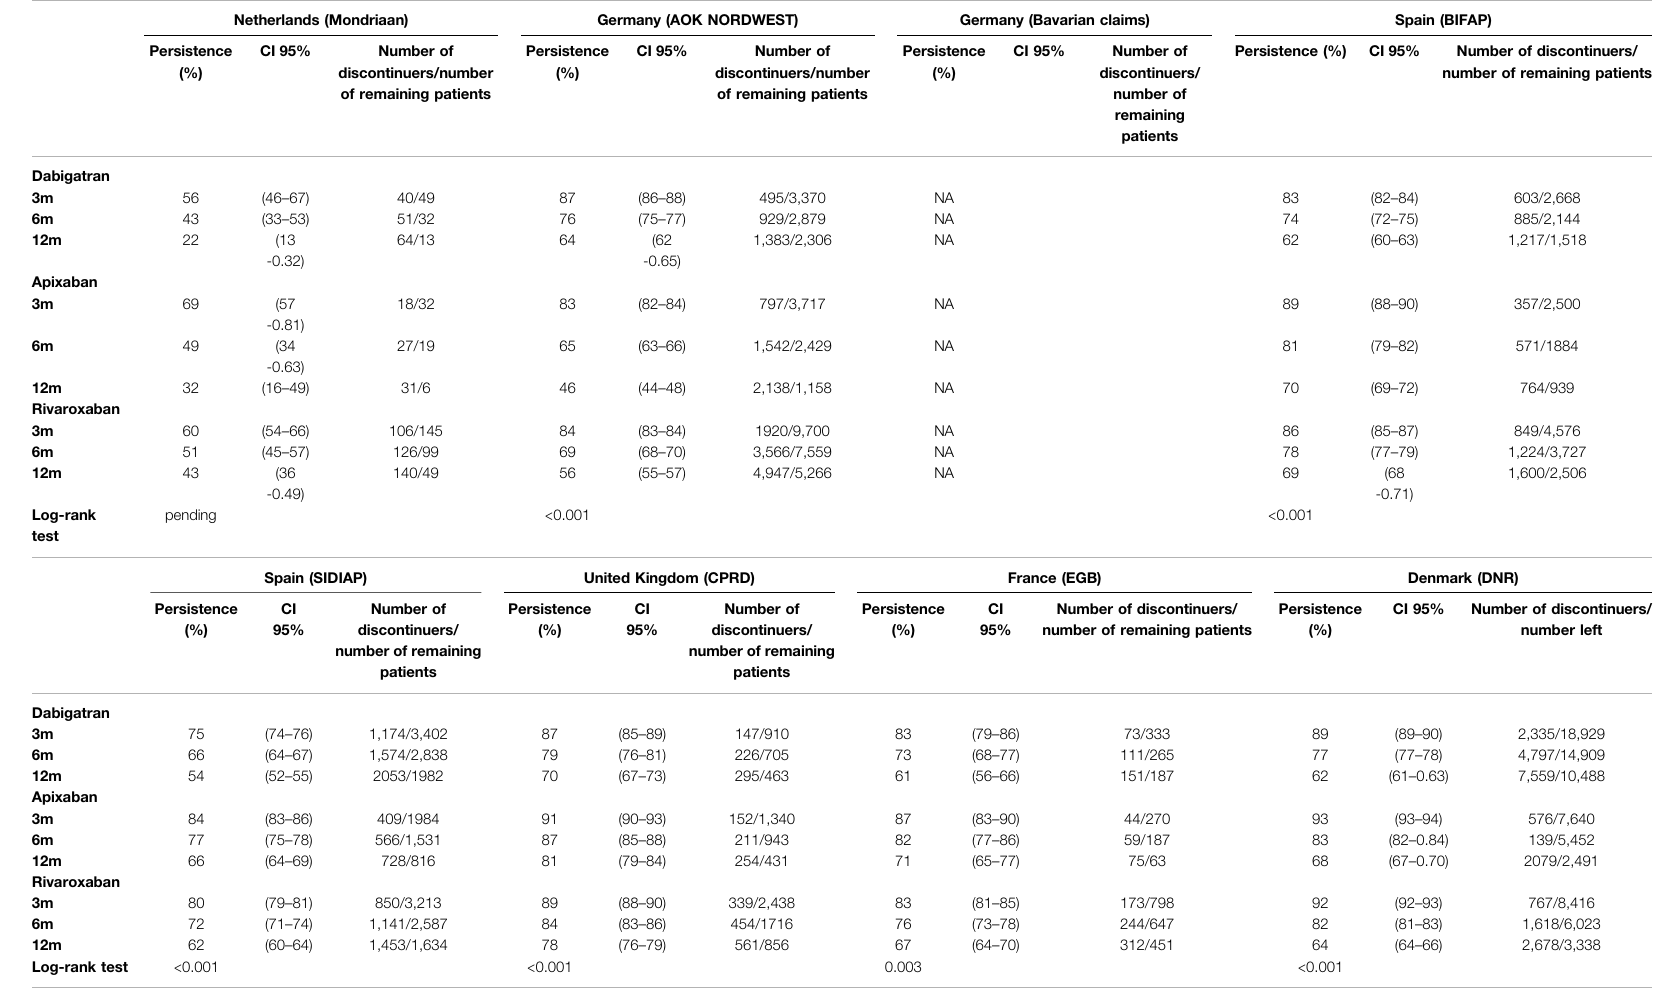
TABLE 2 | Persistence rates at 3, 6, and 12 months by individual DOACs in each